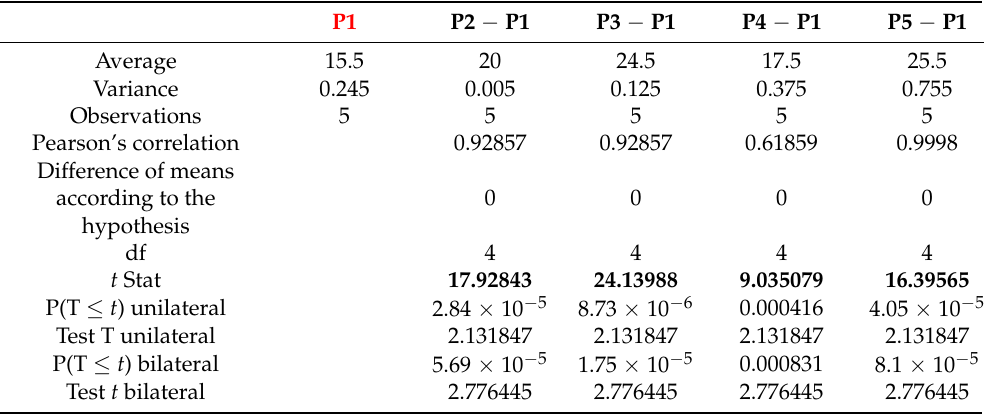
Table 4. Within-subject comparison (comparison of samples to baseline P1) Two-sample t -test for the